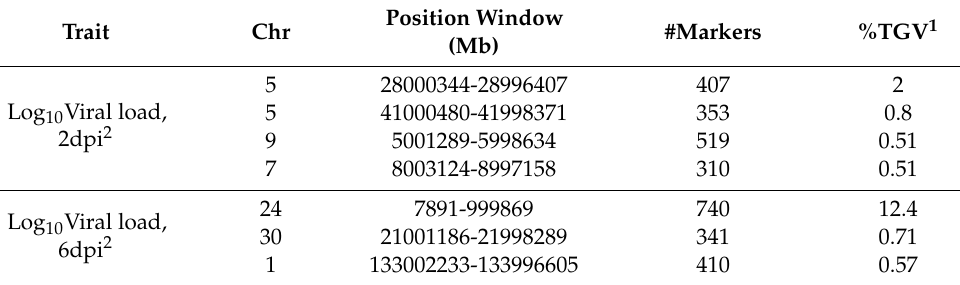
Figure 4. Manhattan plots showing the genome-wide association results for post-infection growth rate using Bayes-B and single-SNP analyses. ( A ) Bayes-B results show the percent of genetic variance explained by 1-Megabase (1-Mb) nonoverlapping windows of SNPs across chromosomes. ( B ) Single- SNP results show the − log 10 ( P value) of ordered SNPs across the chromosomes. The blue and reds lines indicate genome-wide significance at 1% genetic variance and 20% suggestive adjusted Bonferroni correction, respectively.